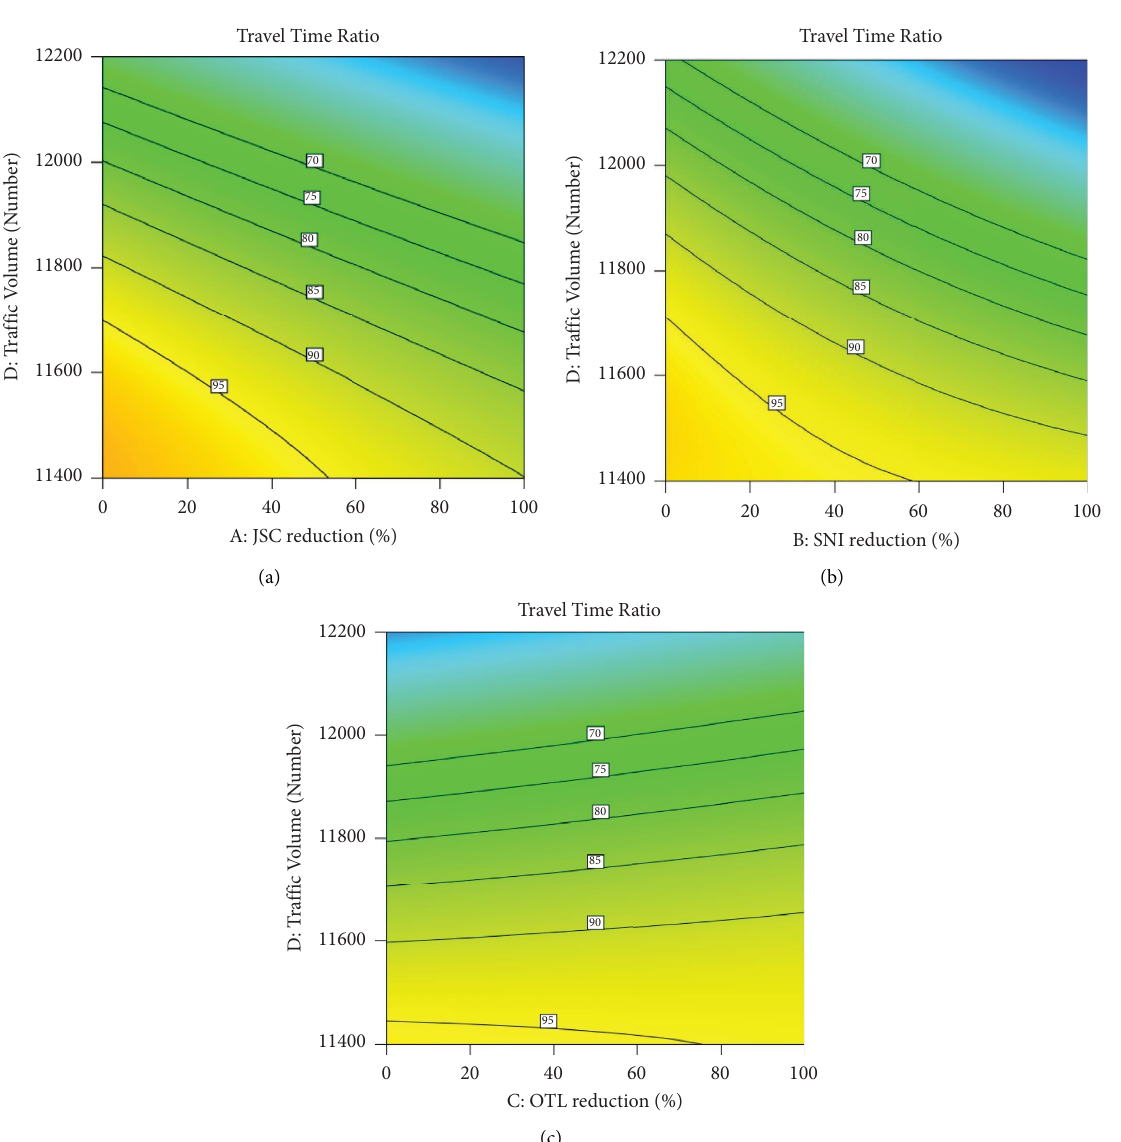
Figure 8: Two-dimensional contour plots of entering trafc volume at the intersection versus (a) JSC, (b) SNI, and (c) OTL for travel time